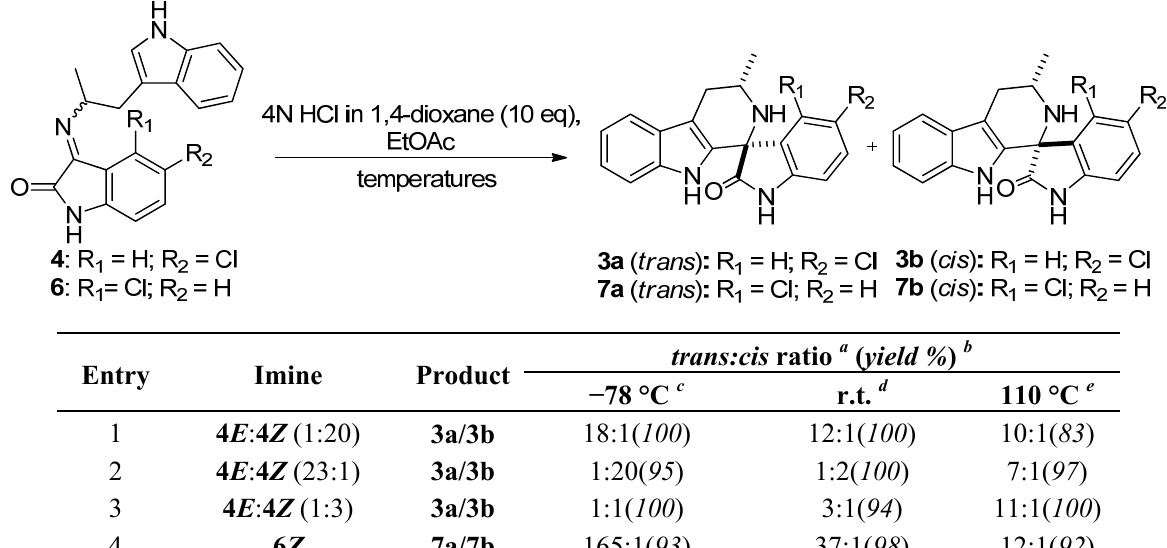
Table 2. Diastereoselectivity of the Pictet-Spengler